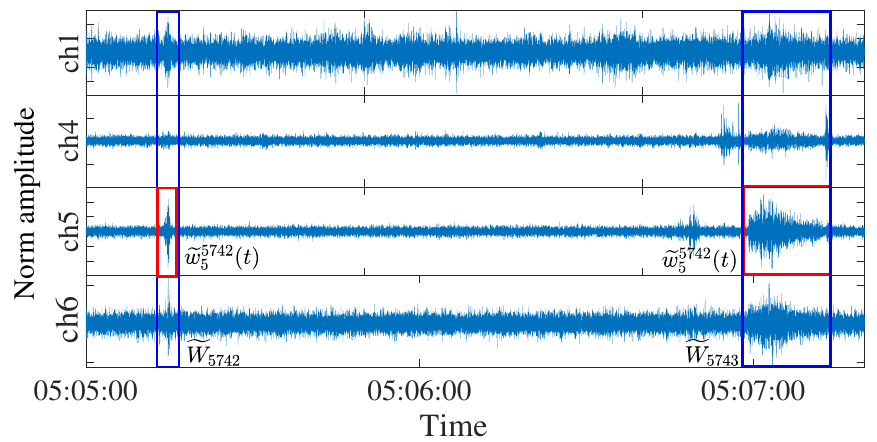
Figure 3. Example of the kept (cid:102) W 5742&5743 (blue rectangular box) and (cid:101) w 5742&5743 as given in Algorithm 1 (Period: 03/November/2013 (05:05:00–05:07:30)).